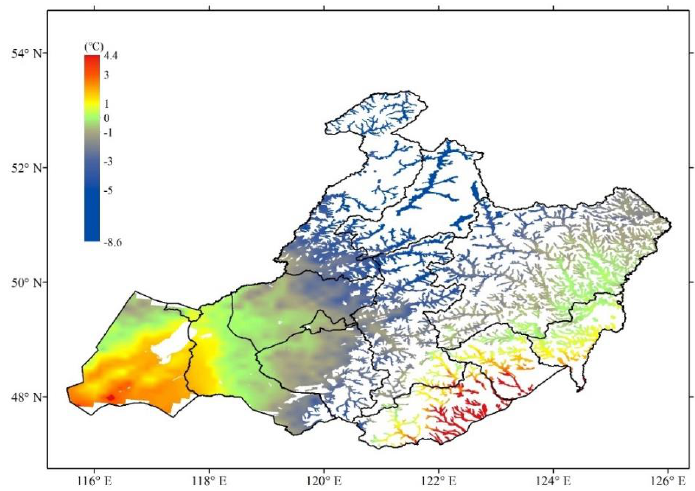
Figure 1. The multiyear annual average temperature during 1979–2015.